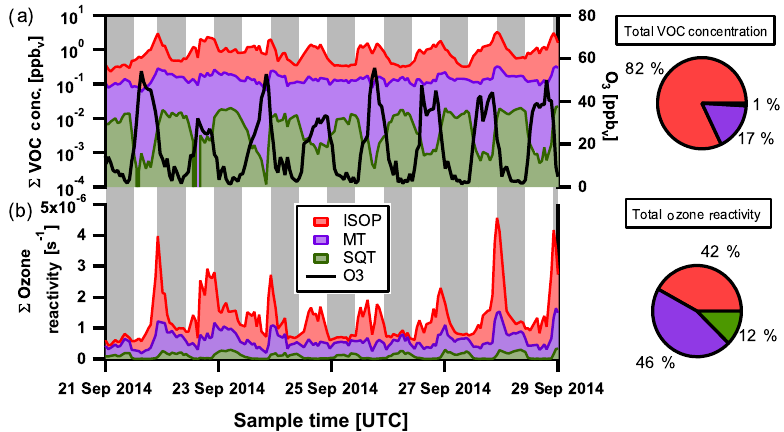
Figure 5. Dry season selected timeline of summed gas-phase VOC concentrations, isoprene (ISOP, red), monoterpenes (MT, purple), and estimated sesquiterpenes (SQTs, green) and ozone concentration (O 3 , black) in panel (a) . Average percentage contributions during the dry season for each group to total VOC concentration are also shown in the top pie chart. Panel (b) depicts the summed contribution to ozone reactivity from isoprene, monoterpenes, and sesquiterpenes. Average percentage contributions during the dry season for each VOC to total ozone reactivity are shown in the bottom pie chart. Local nighttime hours indicated in grey. Local time is − 4h relative to